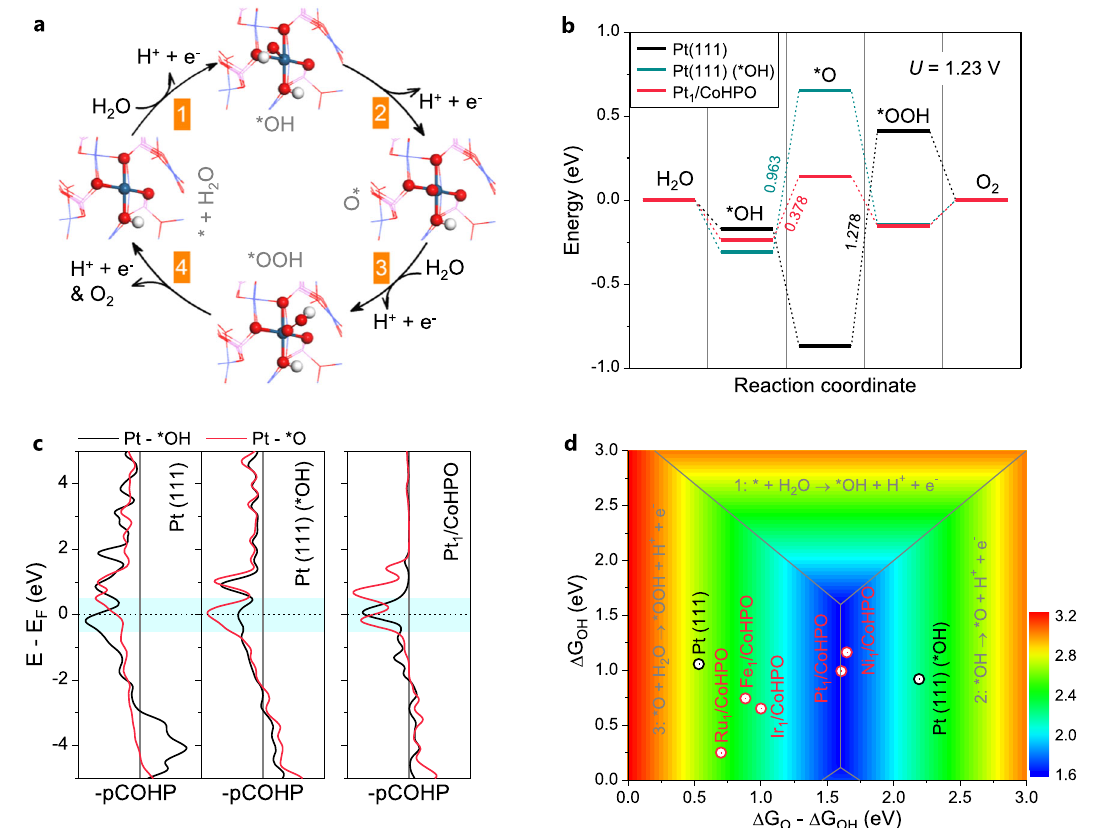
Fig. 4 DFT simulations of catalytic activity and electronic structure. a The OER reaction pathway on Pt 1 /CoHPO. The adsorption structures of intermediates on the HO 1 -Pt 1 -O 3 /Co(P) sites are shown in the insets . Cyan, red, and white spheres represent Pt, O, and H atoms, respectively. b The OER free energy diagram for Pt (111), OH-covered Pt (111), and Pt 1 /CoHPO surfaces at equilibrium potential of 1.23 V. c The projected crystal orbital Hamilton population (pCOHP) for Pt-O bond in the *OH and *O adsorbed Pt (111), Pt (111) (*OH), and Pt 1 /CoHPO surfaces. Bonding and antibonding states are shown on the right and left, respectively. d Overpotential contour map in terms of the free energies of *OH and difference between *O and